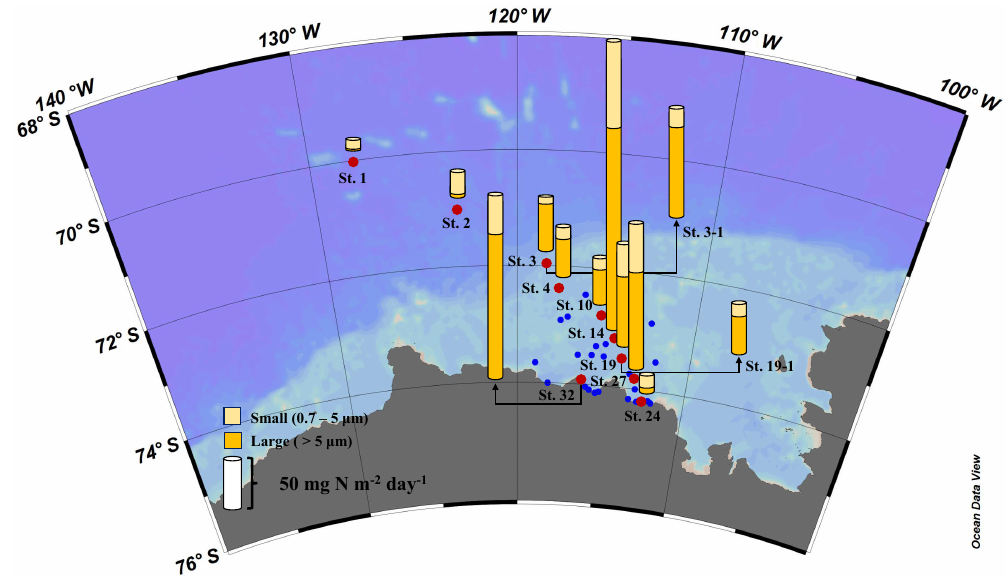
Figure 6. Water-column-integrated daily ammonium uptake rates (mgNm − 2 d − 1 ) of small (0.7–5µm) and large (>5µm) phytoplankton.